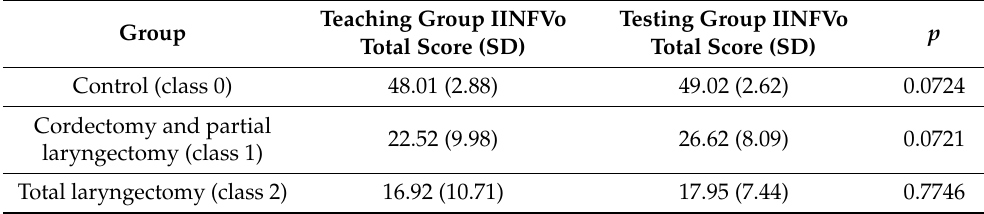
Table 3. Results of auditory-perceptual speech